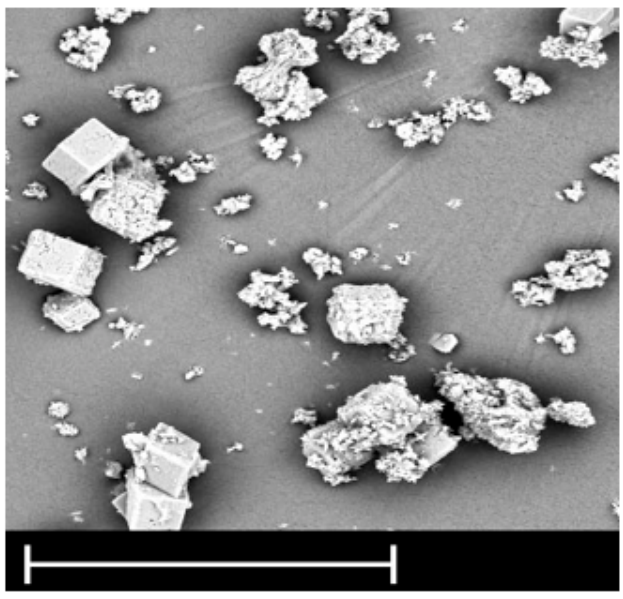
Figure 6. SEM image of deposit from the membrane after cleaning (line: 10 µm).